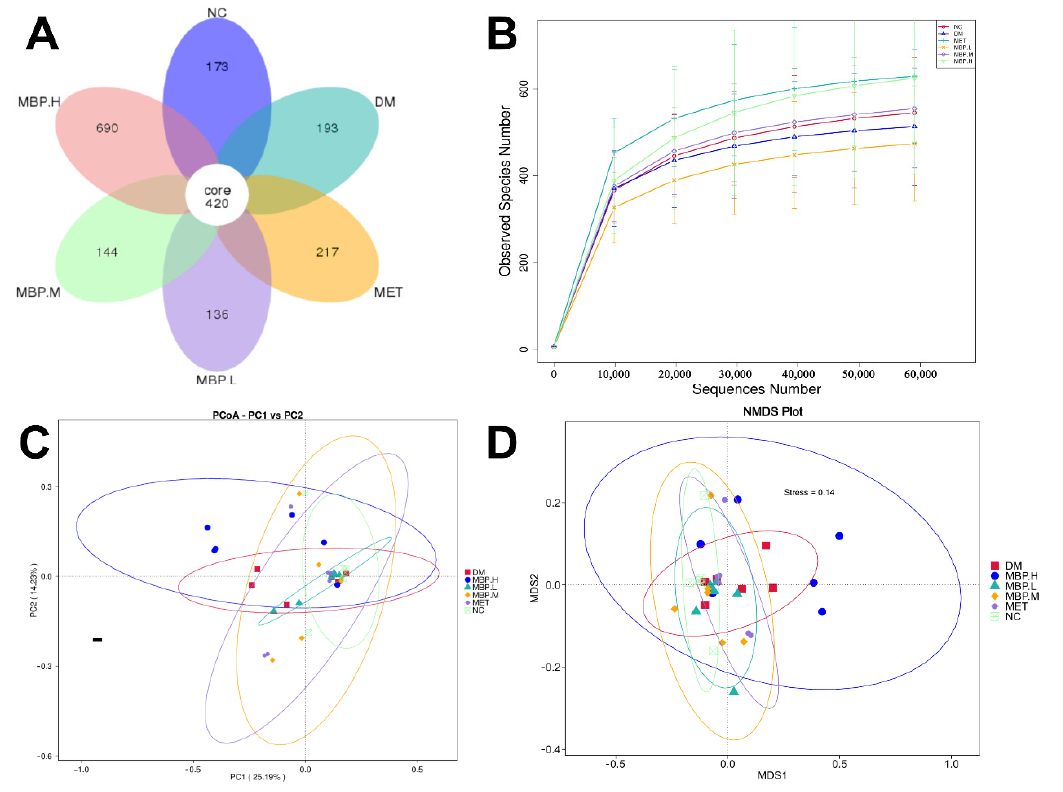
Figure 7. Flower figure ( A ), Rarefaction analysis ( B ), Unweighted UniFrac-based PCoA ( C ) and NMDS analysis ( D ). Table 1. MBP regulates alpha diversity of gut microbiota in